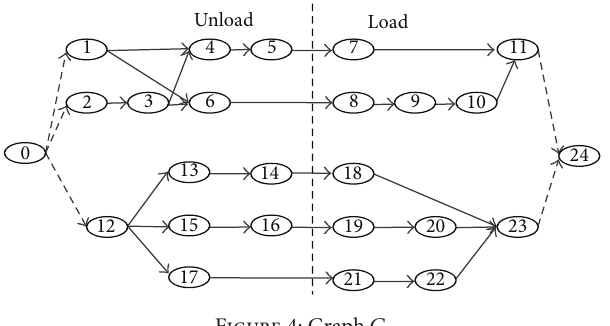
Figure 4: Graph 𝐺